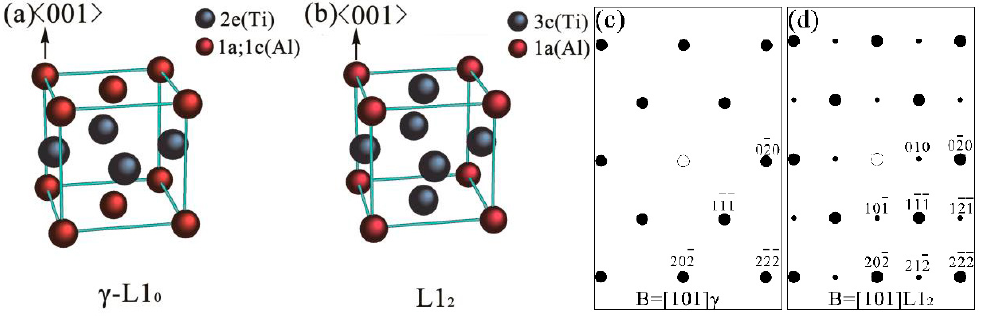
Figure 5. Supposed schematic models and schematic diffraction patterns of the ( a,c ) γ and ( b , d ) L1 2 phases.